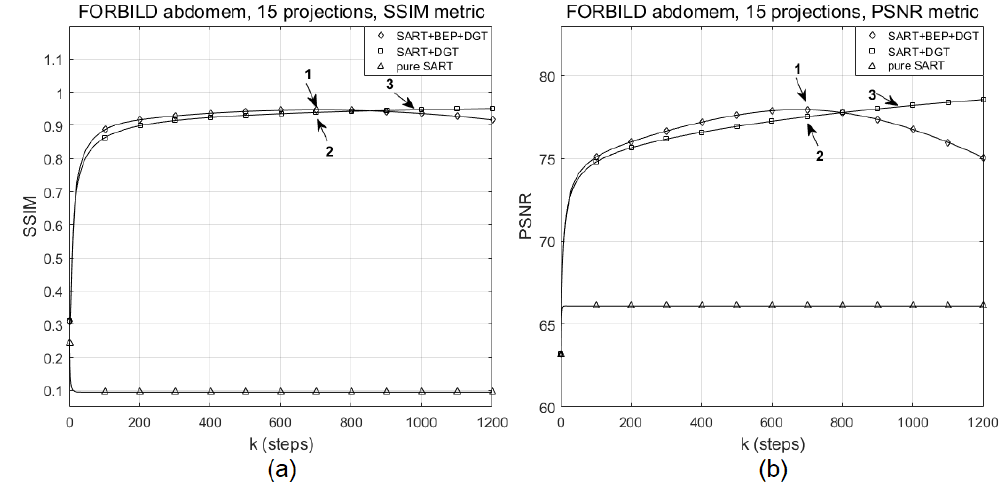
Figure 9. Evolution of ( a ) SSIM and ( b ) PSNR values for a particular reconstruction of the FORBILD abdomen phantom with 15 projections for pure SART, SART+DGT, and SART+BEP+DGT methods.